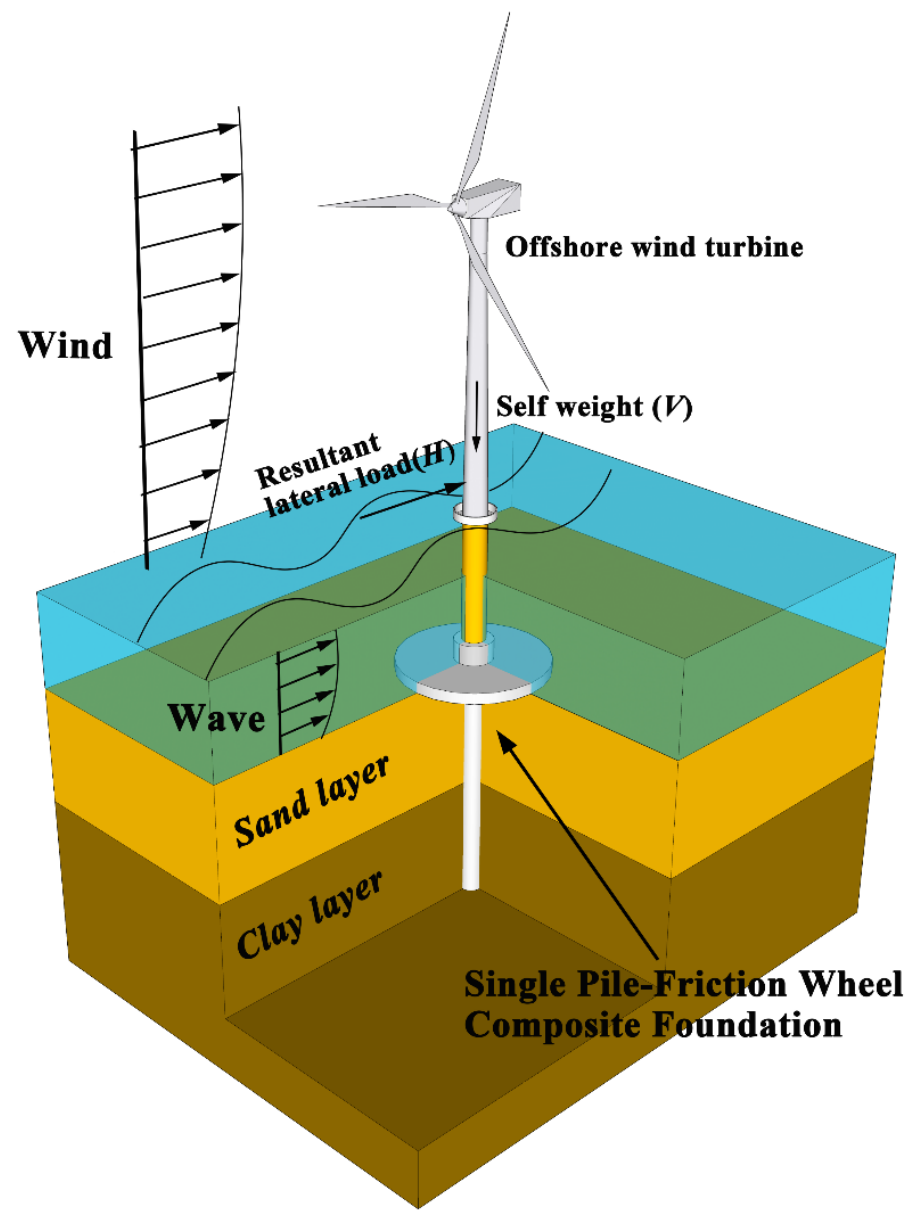
Figure 1. Schematic of single pile-friction wheel composite foundation.